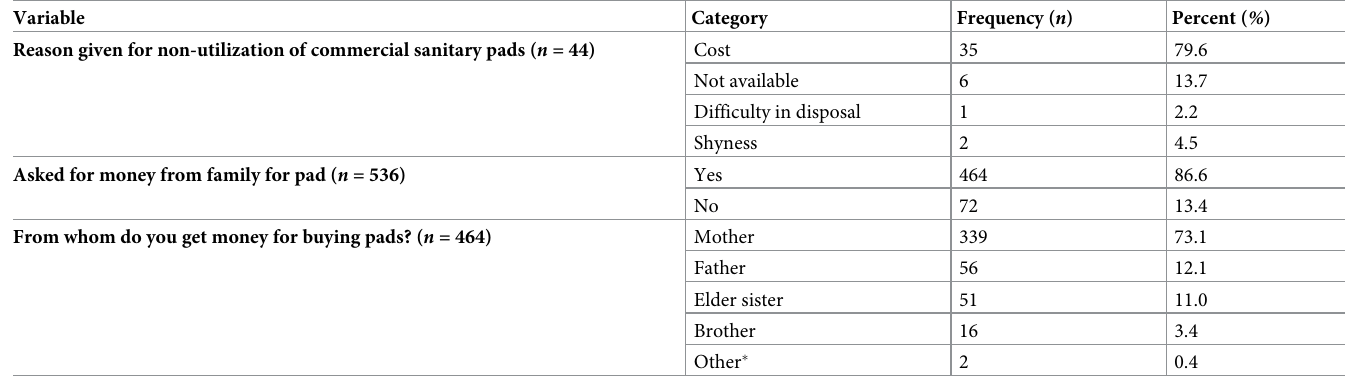
Table 7. Sanitary pad-related issues among high -school girls of Dessie City, Amhara Region, northeastern Ethiopia, 27 January to 6 March 2020. Variable Category Percent ( % ) Reason given for non-utilization of commercial sanitary pads ( n =